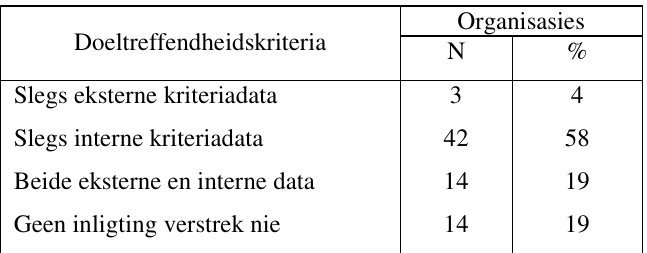
DOELTREFFENDHEIDSKRITERIA GEBRUIK IN EVALUERING VAN